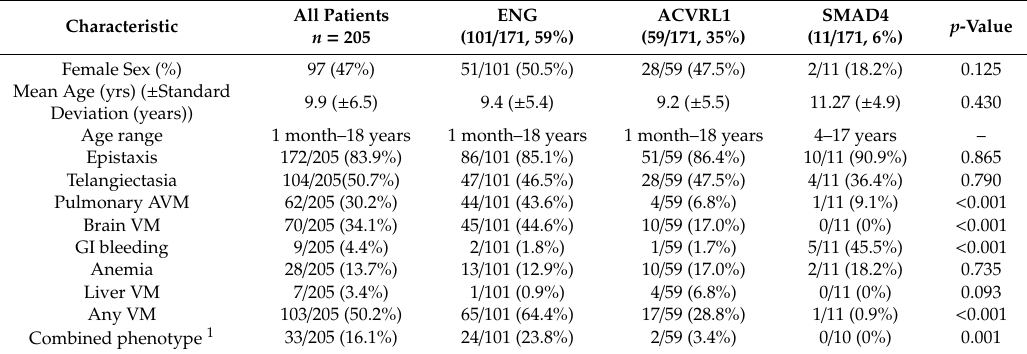
Table 1. Demographic and clinical characteristics of pediatric HHT